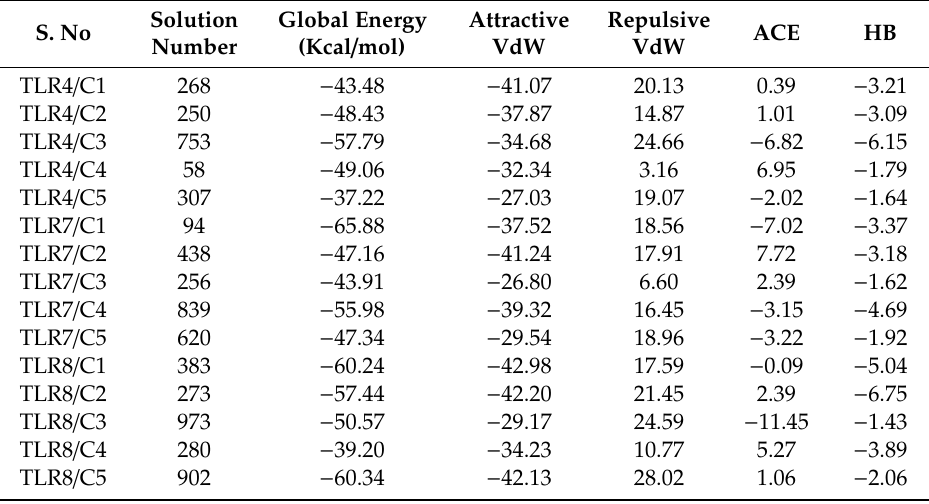
Table 5. Docking results of TLR4, TLR7, and TLR8 with five vaccine constructs. Global Energy S. No (Kcal / mol)